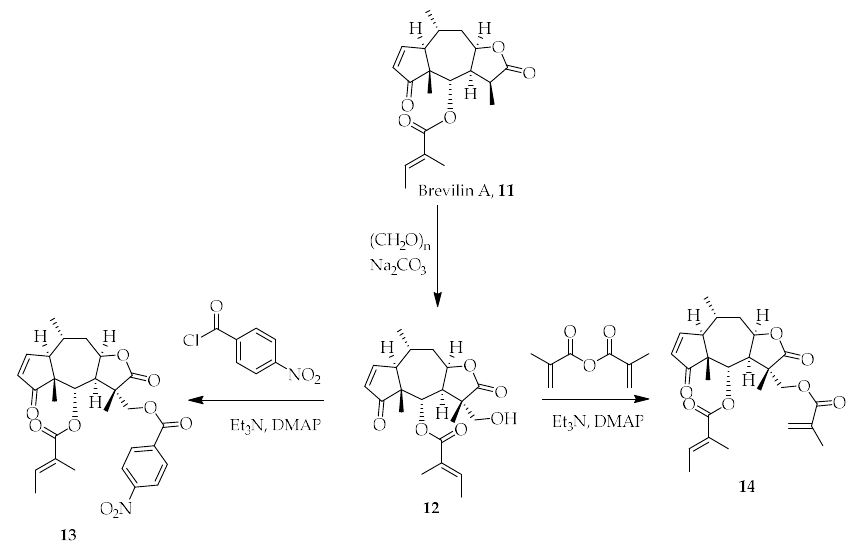
Figure 1. Chemical structures of some heterocyclic compounds used for treating various types of